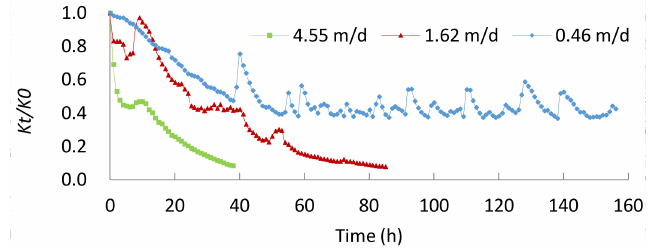
Figure 2. Permeability in the porous medium for three flow velocities.